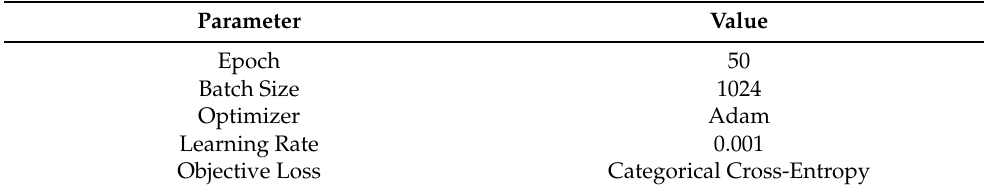
Table 6. Summary of MLP configuration.